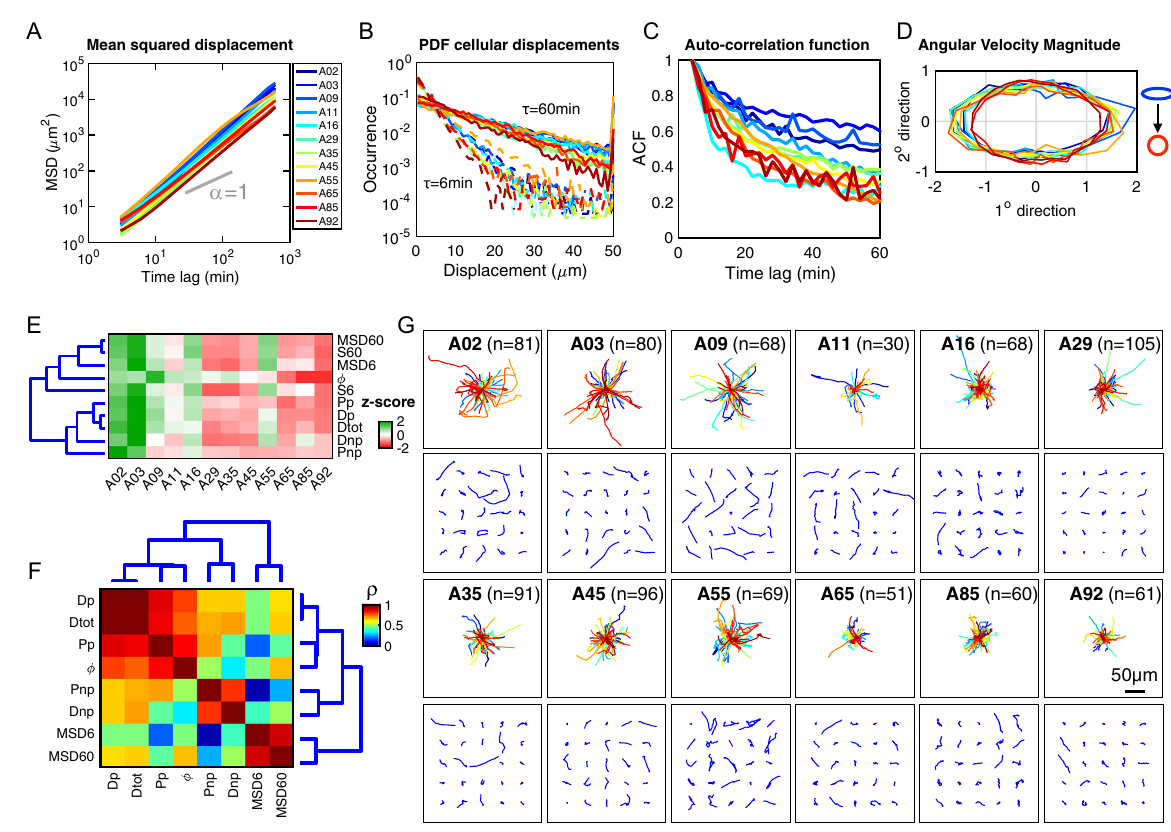
Fig. 1 Global decrease in ensemble cell motility with increasing age. A Age-dependent mean-squared displacements (MSD) of dermal fi broblasts with color code indicating the age of the donor (blue-to-red), an exponent alpha of 1 denotes pure diffusion. B Age-dependent probability functions of cell displacements at time lags equal to 6 min (dashed lines) and 60 min (solid lines). C Auto-correlation function of velocities (ACF) measured at 3 min time lags. D Angular velocity magnitudes as a function of the donor age, “ circular ” denotes similar likelihood for all angles and “ ellipsoidal ” indicating a polarization of cell movements along primary axis of migration. Color coding in B also applies to C , D . E Heatmap showing the magnitude of the correlation between motility parameters ( z -score normalized) and age. Dendrogram branches indicate unsupervised hierarchical clustering with ward linkages of the cityblock distances of parameters. Red-to-green signi fi es low-to-high Pearson correlation coef fi cient. These parameters include total diffusion (Dtot), diffusion along the primary and secondary axes of cell movements (Dp and Dnp), measure of the spatial persistence — anisotropy of the cell movements ( ϕ ), persistence time of cell motion along the primary and secondary axes of cell movements (Pp and Pnp), average cell speed at time lags of 6 and 60 min (S6 and S60), and the MSD measured at time lags of 6 and 60 min (MSD6 and MSD60). F Heatmap showing the magnitude of cross correlations of motility parameters across all cells for all ages, range of Pearson correlation coef fi cients = 0.39 – 0.94. G Cell migration patterns and trajectories for primary dermal fi broblasts collected from healthy donors with ages spanning 2 – 92 years. Top panels show origin-centered trajectories for all cells per age; bottom panels show a grid of x – y trajectories for 25 randomly selected cells per age. The number of tracked cells per sample is indicated in the upper left corner of the